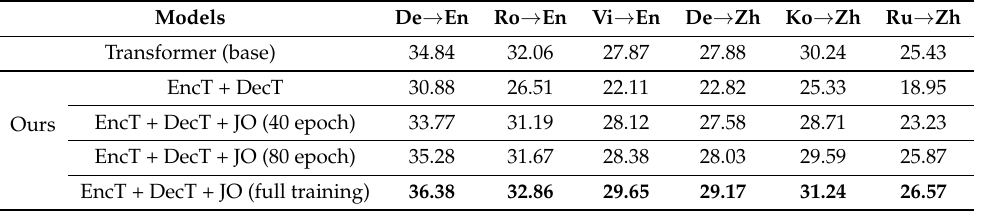
Table 5. The effectiveness of joint optimization. EncT, DecT, JO represent encoder training, decoder training, and joint optimization, respectively.